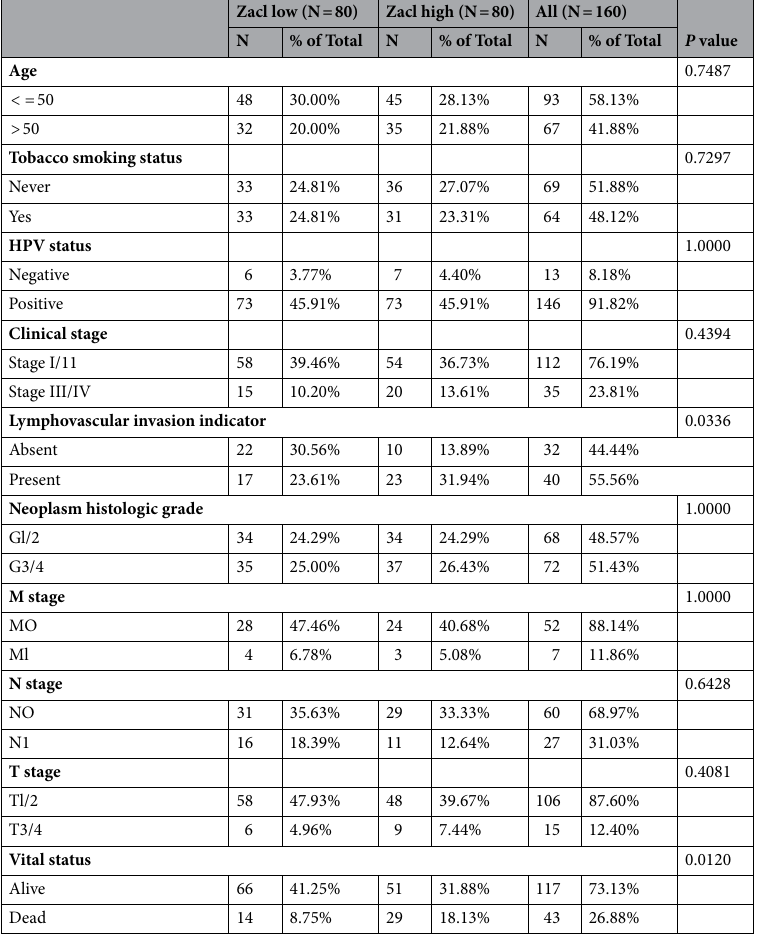
Cervical cancer with high Zac1 expression is significantly associated with EMT comparing to normal tissues. To assess the association between cervical cancer tumors of different Zac1 expressions and normal tissues, we analyzed the GSE7803 database that consists of 21 cervical cancer tumor samples and 10 nor- mal tissues. Zac1 expression from 21 cervical cancer tumor were divided into two groups: 50% from top as high Zac1 expression (10 patients) and 50% from bottom as low Zac1 expression (11 patients), in which the mean Zac1 expression in cervical cancer with high Zac1 is similar to normal cervix epithelium, implying that high Zac1 expression may not resulted by amplified copy number in the cancer tissue (Fig. 4A). GSEA was performed to compare high or low Zac1 expression tumor samples to normal tissues respectively. The Hallmark gene sets that are statistically meaningful in both groups were presented in Fig. 4B. In a consistent aspect, tumor tissue had significantly enriched cell proliferation and a significant suppression of the p53 pathway compared to normal tis- sue. In terms of inconsistency, we found that gene pattern in tumor with high Zac1 expression was significantly correlated with EMT, whereas the one with low Zac1 expression was significantly negatively correlated with EMT comparing with normal tissues as well as “K-ras signaling Up” (Fig. 4B).